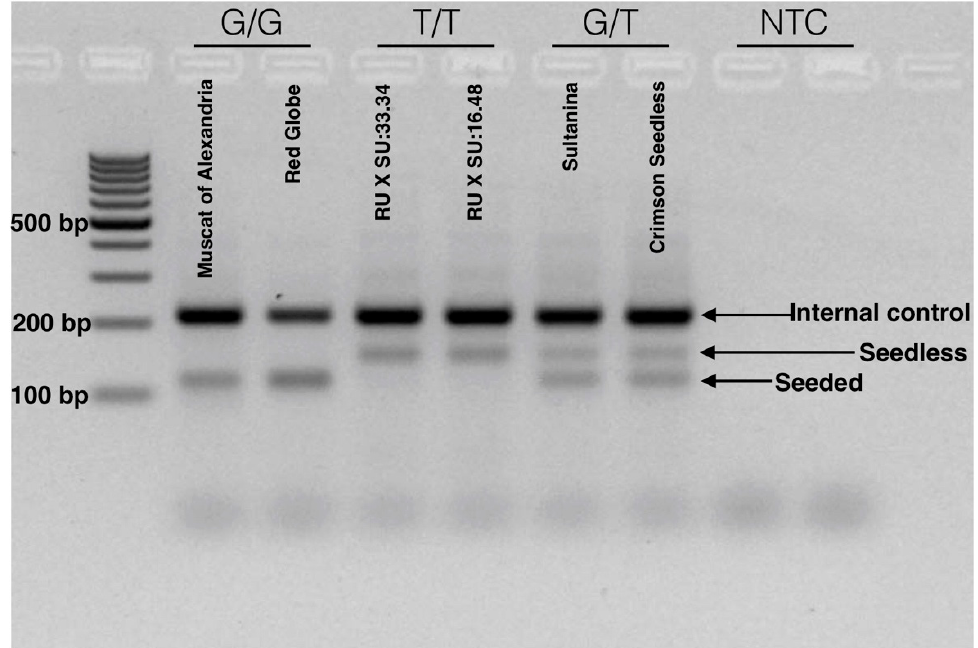
Figure 8. Tetra-ARMS PCR electrophoretic analysis for the detection of the SNP [G/T] with the e7_VviAGL11 marker. The SNP marker is responsible for the Arg-197-Leu mutation in the coding sequence of VviAGL11. The electrophoretic profile compares seeded genotypes (Muscat of Alexandria and Red Globe) with homozygous seedless (RU × SU:16.48 and 33.34 experimental genotypes) and heterozygous seedless (Sultanina and Crimson Seedless) genotypes. Seeded and seedless alleles produce specific products of 115 and 150 bp, respectively. Both alleles amplify the internal control product of 212 bp. A developed marker is suitable for the application in simple routines based on standard PCR and agarose electrophoresis.